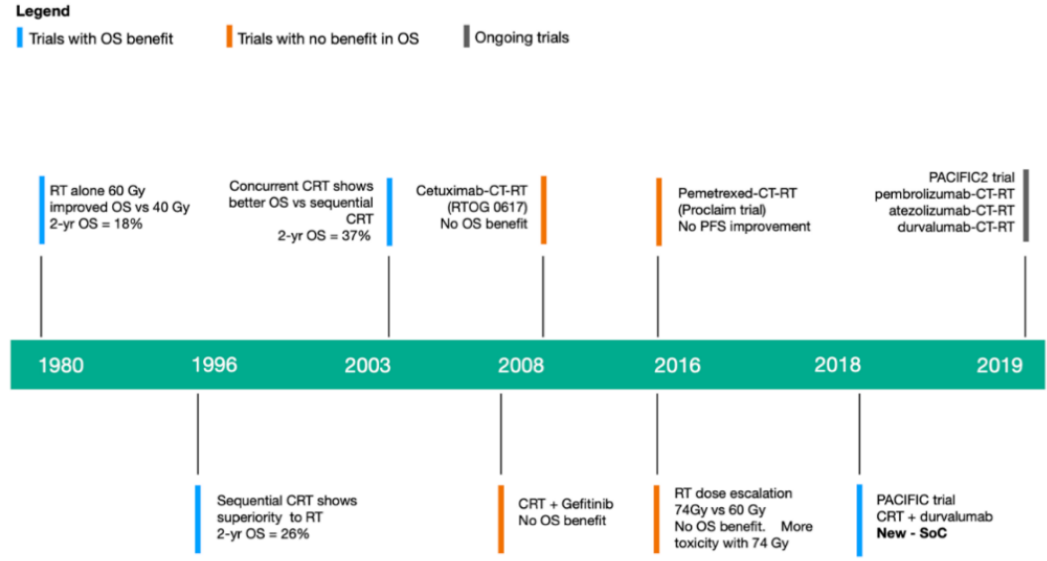
Figure 2. Timeline illustrating the evolution of treatments for NSCLC. RT: radiotherapy. CT: chemotherapy. CRT: Chemoradiotherapy. OS: overall survival. PFS: progression-free survival. Yr: year. SoC: standard of care.